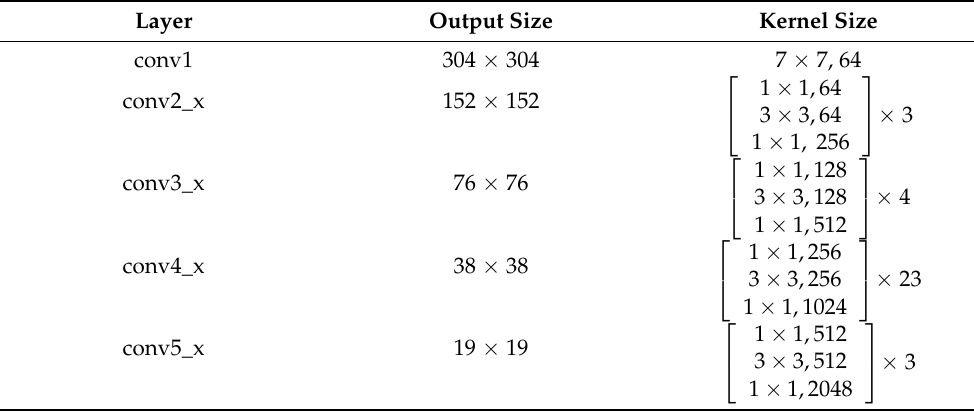
Table 1. Applied kernels of ResNet101 in